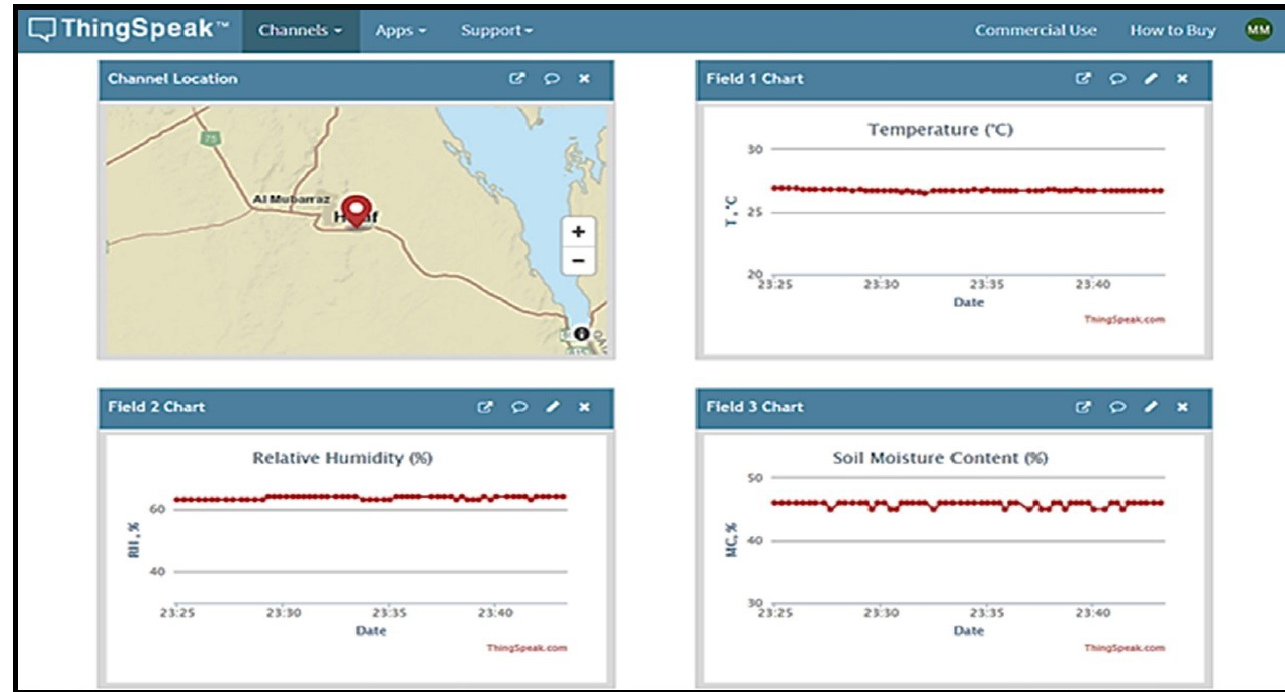
Figure 6. A screenshot of the received microclimate measurements for humidity, temperature, and soil moisture content, via the ThingSpeak